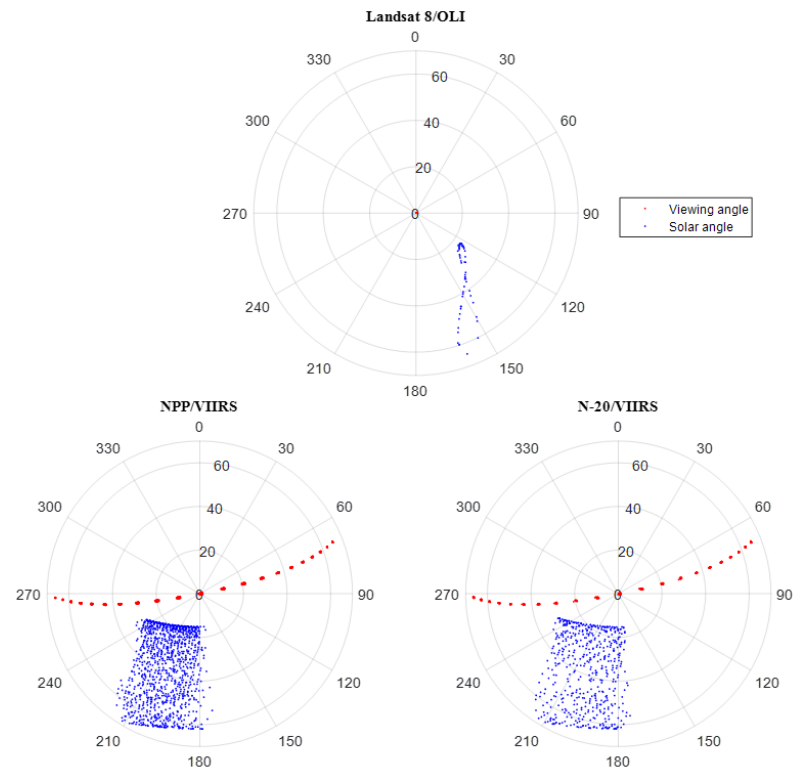
Figure 3. Solar (blue) and viewing (red) angular distribution of Landsat 8/OLI, SNPP/VIIRS, and NOAA-20/VIIRS, and the time periods are 22 May 2013 to 12 May 2021, 2 April 2013 to 20 July 2021, and 13 February 2018 to 20 July 2021, respectively. The angular direction (degrees east of north) in polar coordinates indicates the azimuth angle and the length of the radius specifies the zenith angle.